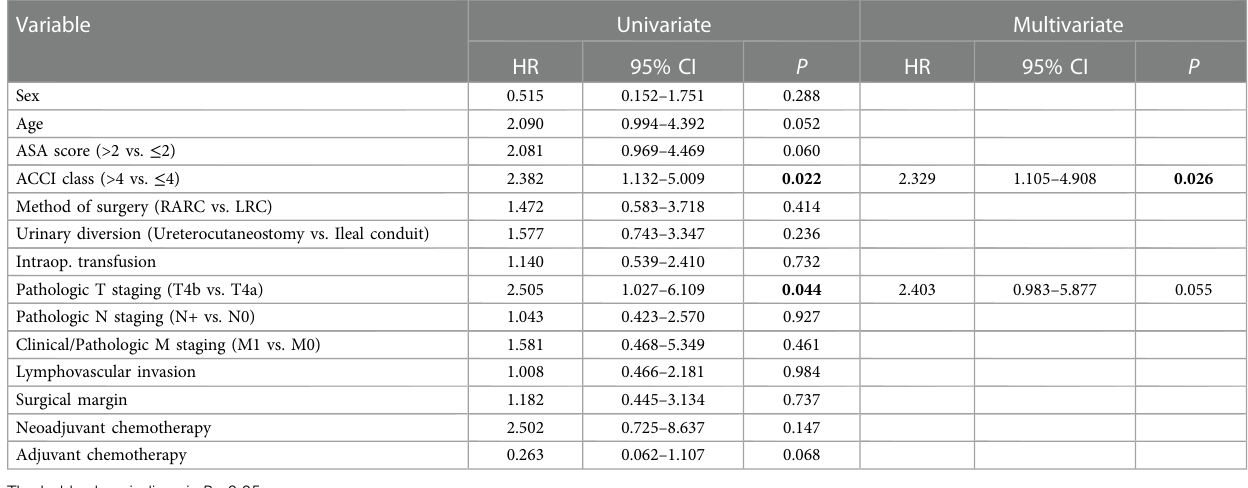
TABLE 3 Univariate and multivariate Cox proportional hazard regression analysis for OS.